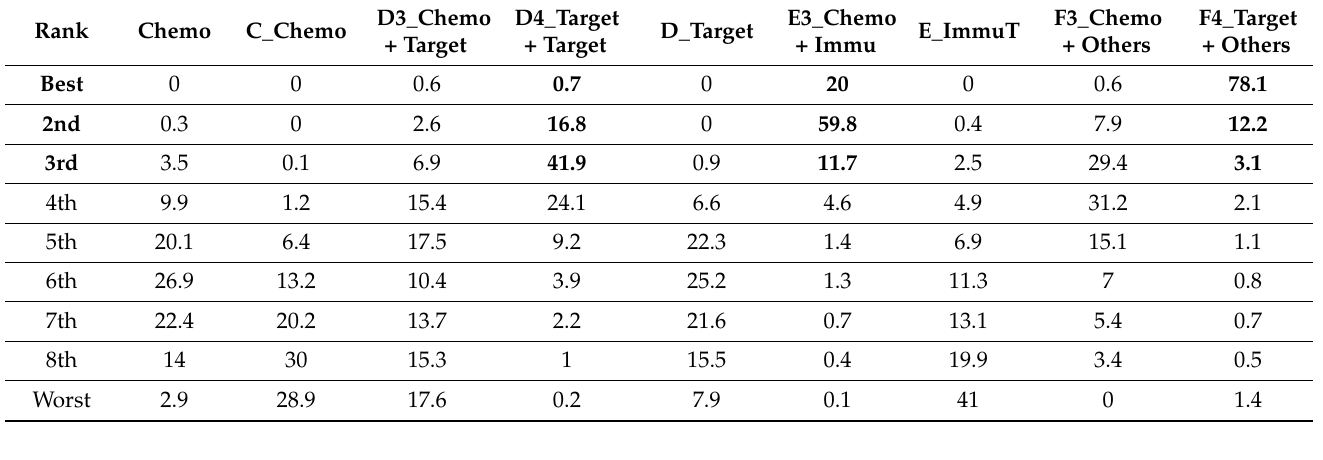
Table 5. Estimated cumulative probabilities (%) of each treatment being the best in disease-free control rate (Advanced Stage, Component I).